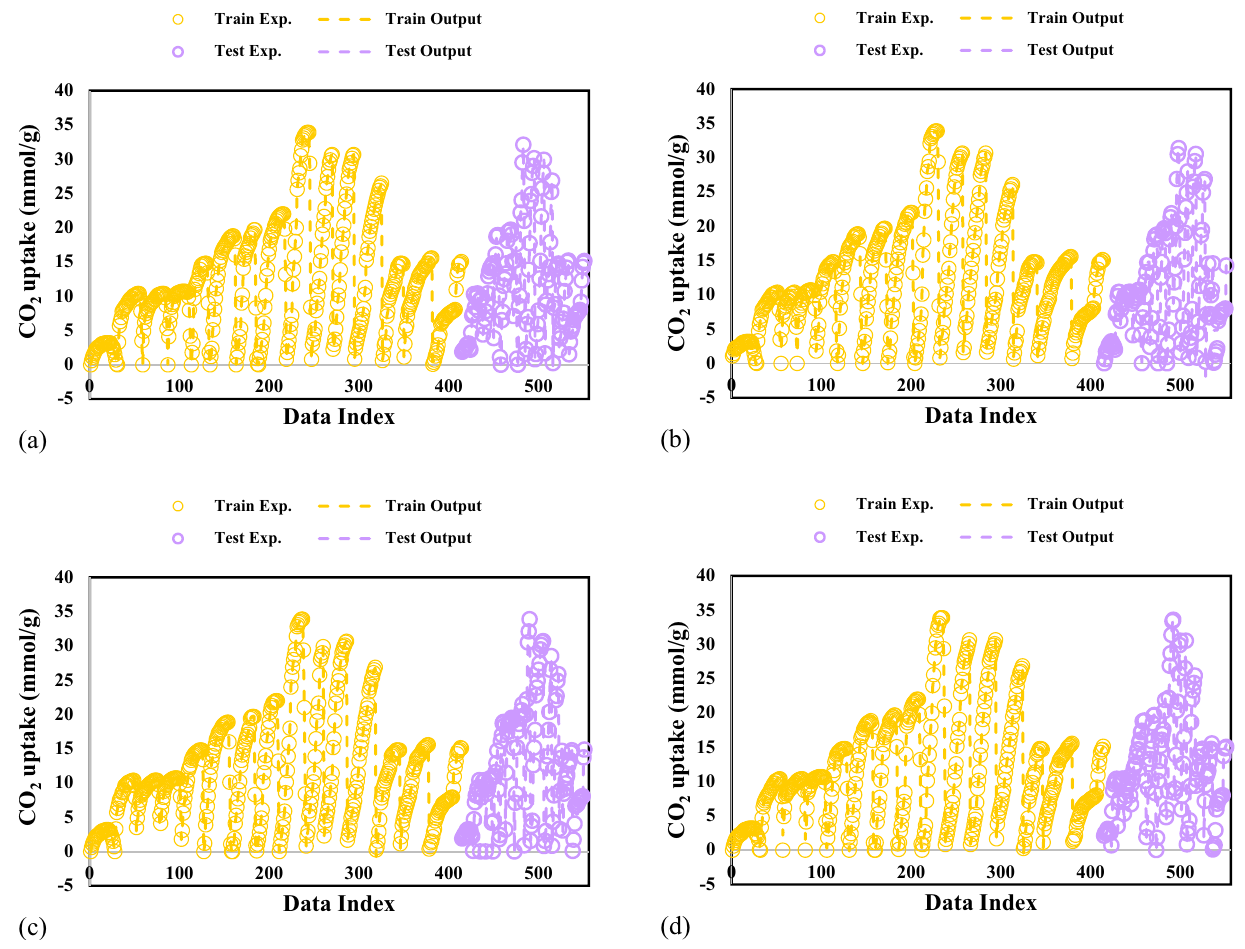
Figure 3. Comparison of experimental values and model outputs for GPR model containing kernel function of ( a ) Exponential, ( b ) Matern, ( c ) Squared exponential and ( d ) Rational